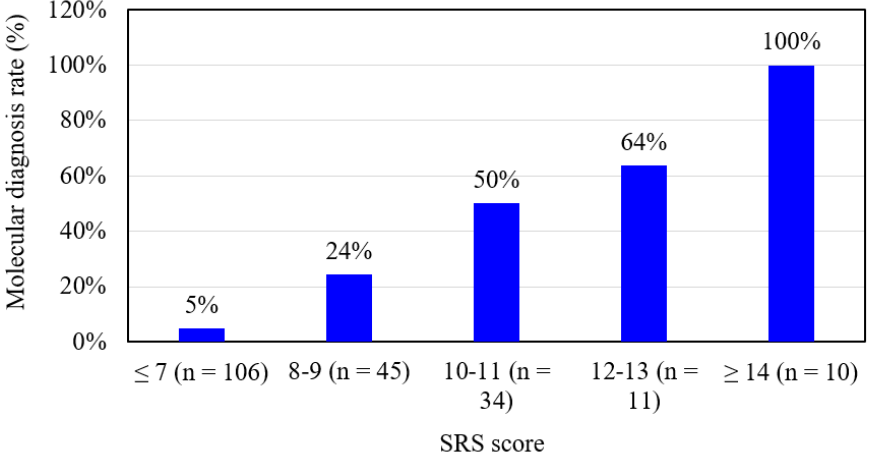
Figure 2. The molecular diagnosis rates of the 206 subjects with a clinical diagnosis of Silver–Russell syndrome (SRS) (SRS score ≥ 8) ( n = 100) or an SRS score ≤ 7 ( n = 106) divided into five groups according to SRS score (maximum = 15).